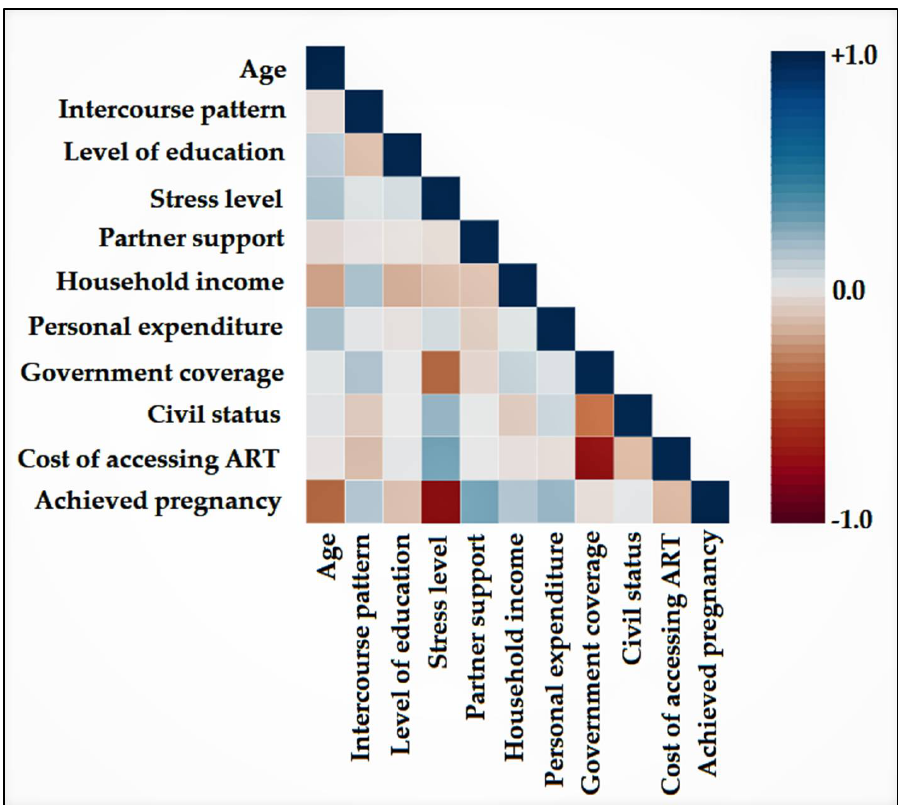
Figure 1. Correlation matrix of variables mentioned in the couple infertility questionnaire. Negative Spearman’s correlation coefficients represented in tones of red color. Positive Spearman’s correlations are represented in tones of blue color. Table 3. Multivariate analysis of factors associated with failing to achieve pregnancy through